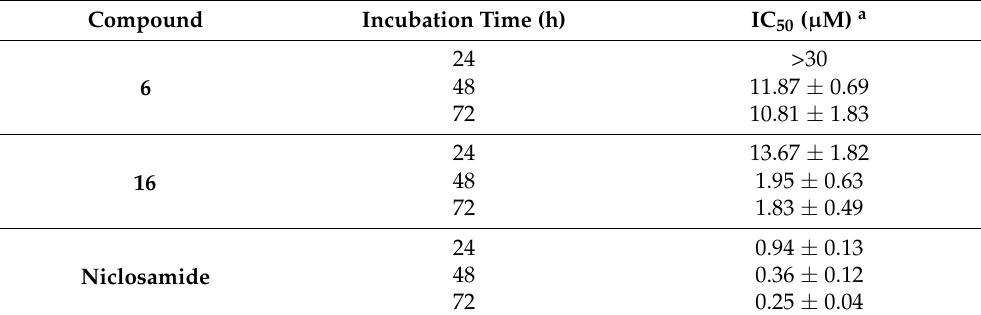
Table 2. Cell proliferation analysis in DU145 cells. Cell proliferation was determined using WST-1 as- say after 24, 48, and 72 h incubation with serial dilutions of tested compounds 6 , 16, and niclosamide.